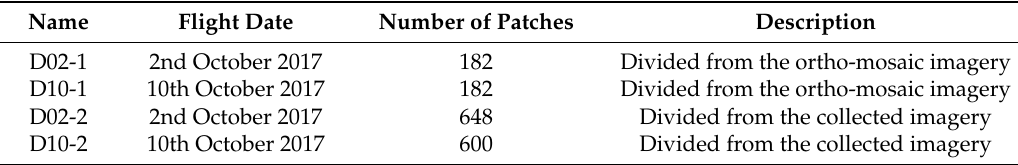
Table 1. Specification for the dataset.